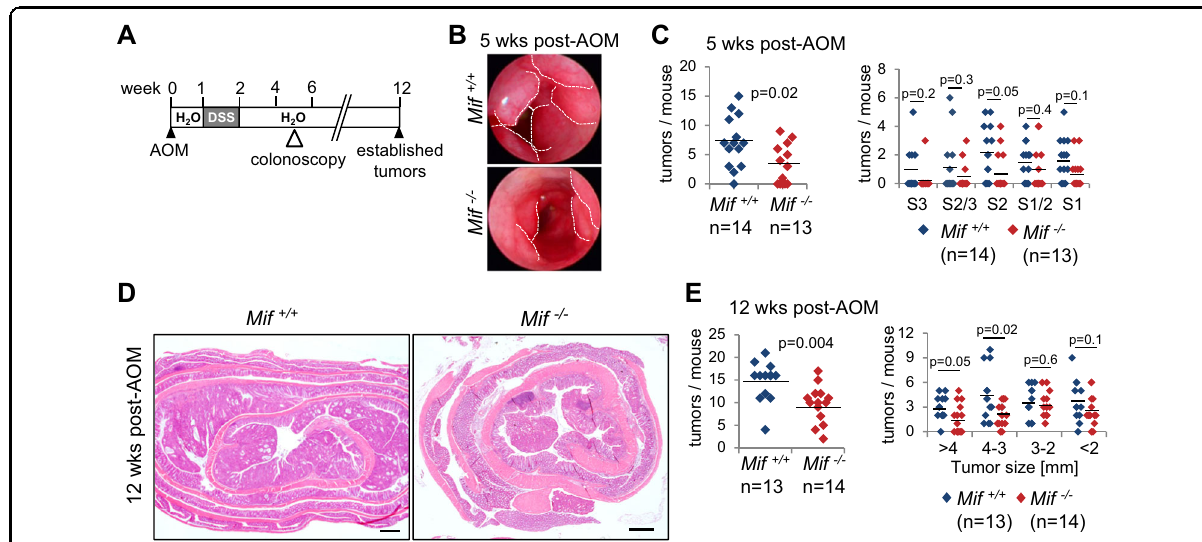
Fig. 1 MIF supports tumor growth in a CRC mouse model. A Schematic of the AOM/DSS CRC mouse model. Visualization of tumor burden started at week 5 by colonoscopy. At 12 weeks post-AOM injection, established tumors were analyzed. B Representative colonoscopy images of the colonic lumen of the indicated genotypes at week 5 post-AOM. Dashed lines indicate the tumor borders. C Average number of tumors (left) and tumor sizes (right) in Mif + / + and Mif − / − mice at 5 weeks post-AOM injection. Numbers were determined by colonoscopy in living mice. S1 = small tumors to S3 = larger tumors. D Representative H&E-stained colonic tissues with tumors from Mif + / + and Mif − / − mice at week 12 post-AOM injection. Scale bars, 600 µm. E Average number of tumors per mouse (left) and tumor sizes (right) of the indicated mice at 12 weeks post-AOM injection. C , E n , mouse numbers. Black lines, mean. Student ’ s t test of indicated